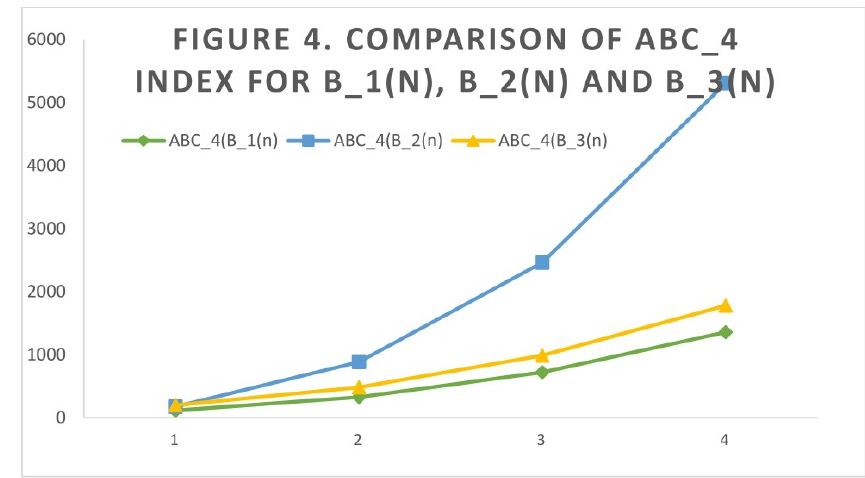
Figure 4. Comparison of ABC 4 index for B 1 ( n ) , B 2 ( n ) , and B 3 ( n )